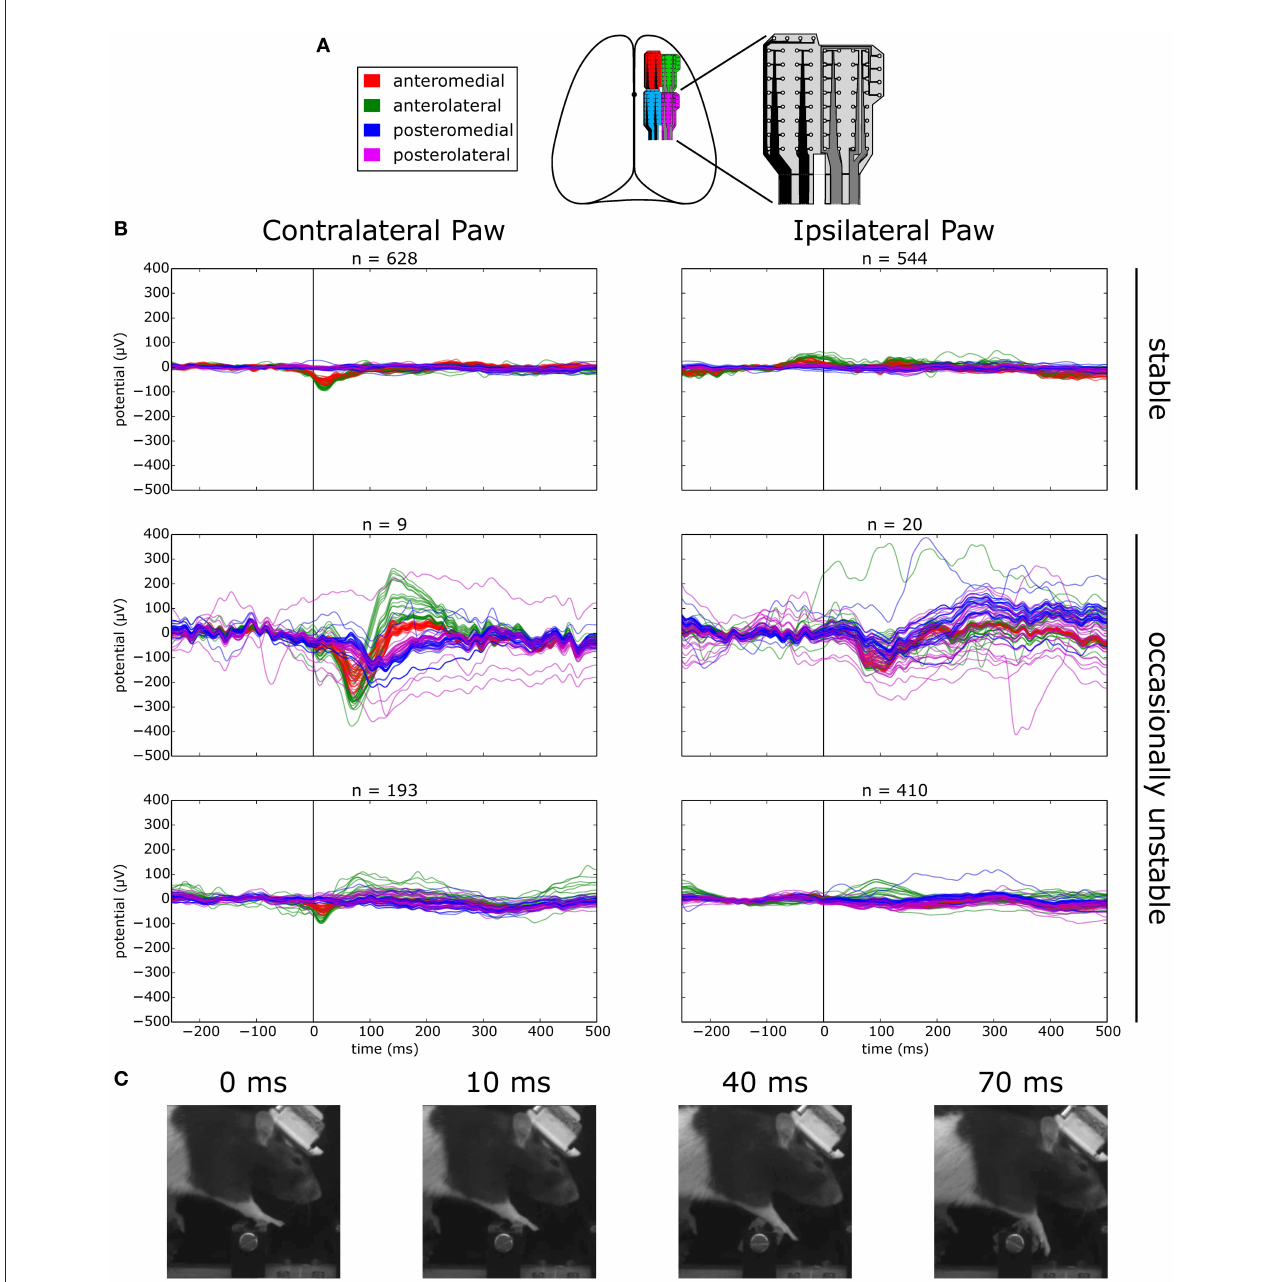
FIGURE11 Evoked responses to stepping on stable vs. occasionally unstable steps. (A) Schematic depicting the location of implanted ECoG grids. (B) Average voltage traces aligned on stepping with the contra- or ipsilateral paw on a manipulated step. Top: sessions where the step was permanently stable. Bottom: sessions where the step was occasionally made unstable. The middle row shows traces for unstable trials and the lower row the traces for the remaining stable trials. (C) Example frames of the behavior of the animal at different time points of an unstable